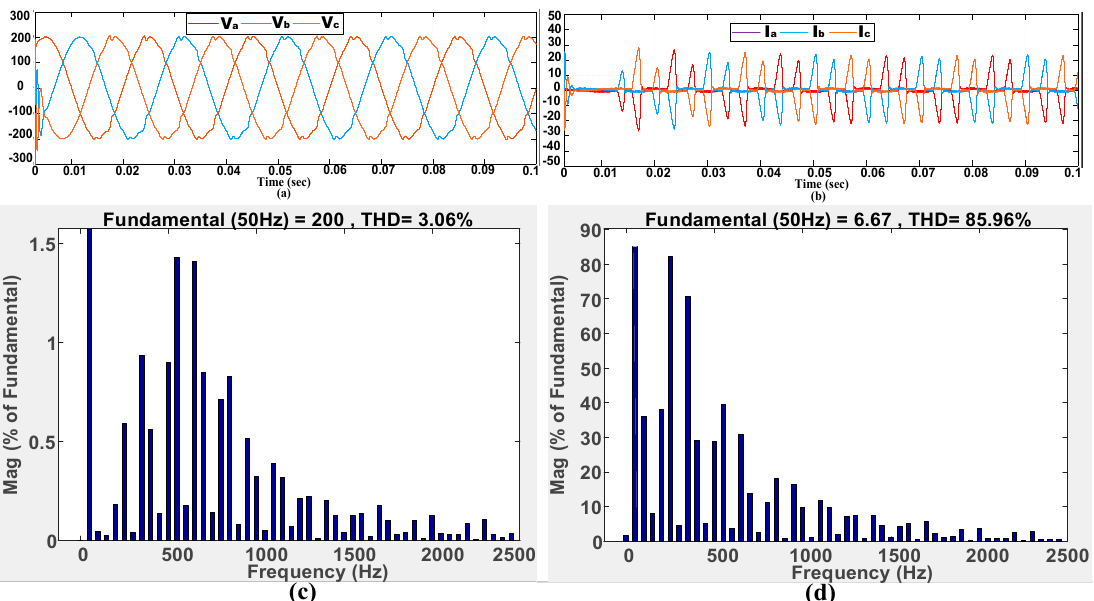
Figure 9. Simulation results with the H ∞ robust controller in steady-state condition with non-linear loads. ( a ) Output voltage, ( b ) Load current, ( c ) THD value of voltage, ( d ) THD value of current.